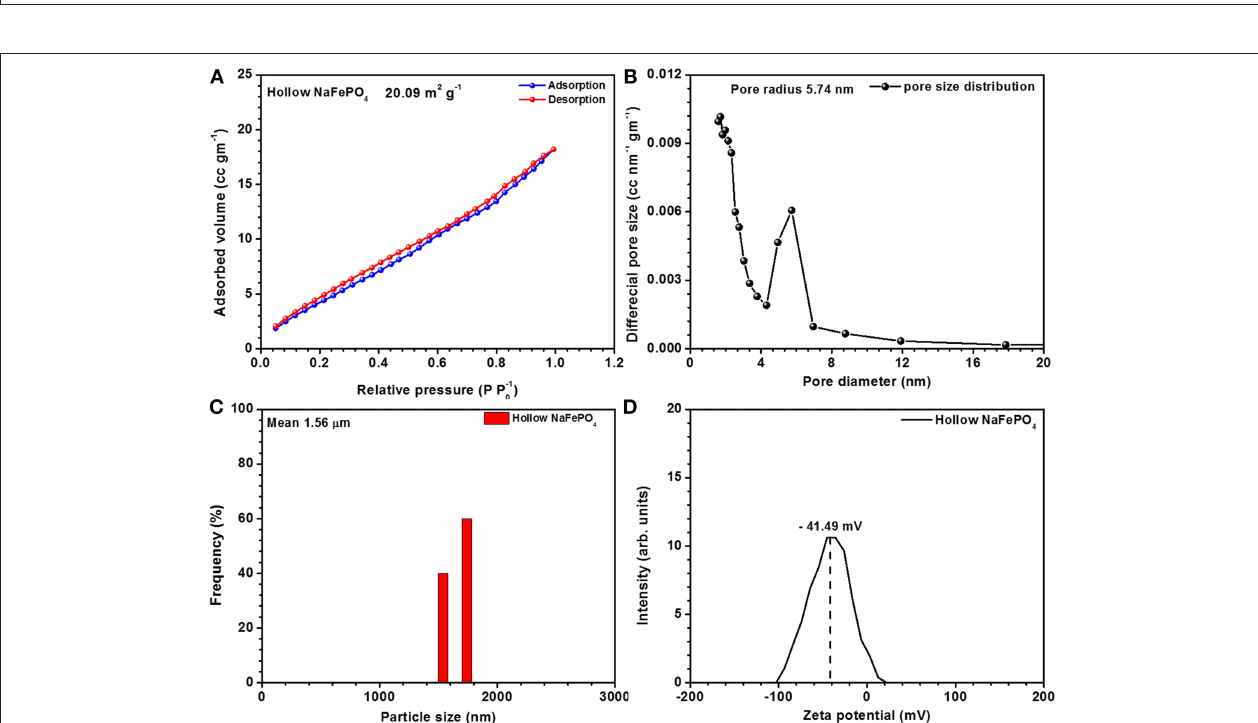
FIGURE 2 | (A) Adsorption-desorption isotherm curves, (B) pore size distribution curves, (C) particle size distribution, and (D) zeta potential curves of hollow NaFePO 4